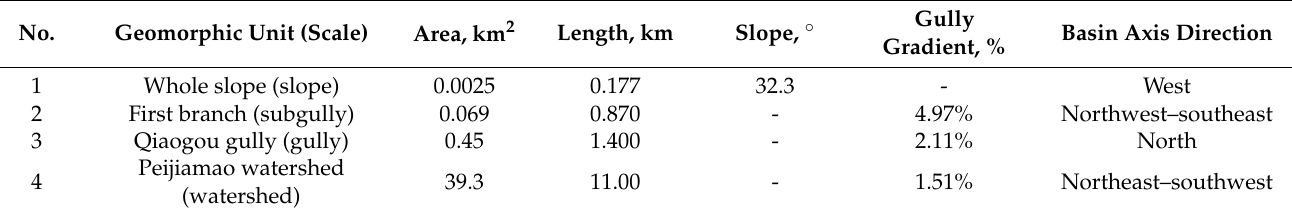
Table 1. Description of field runoff plot and gauging watershed.